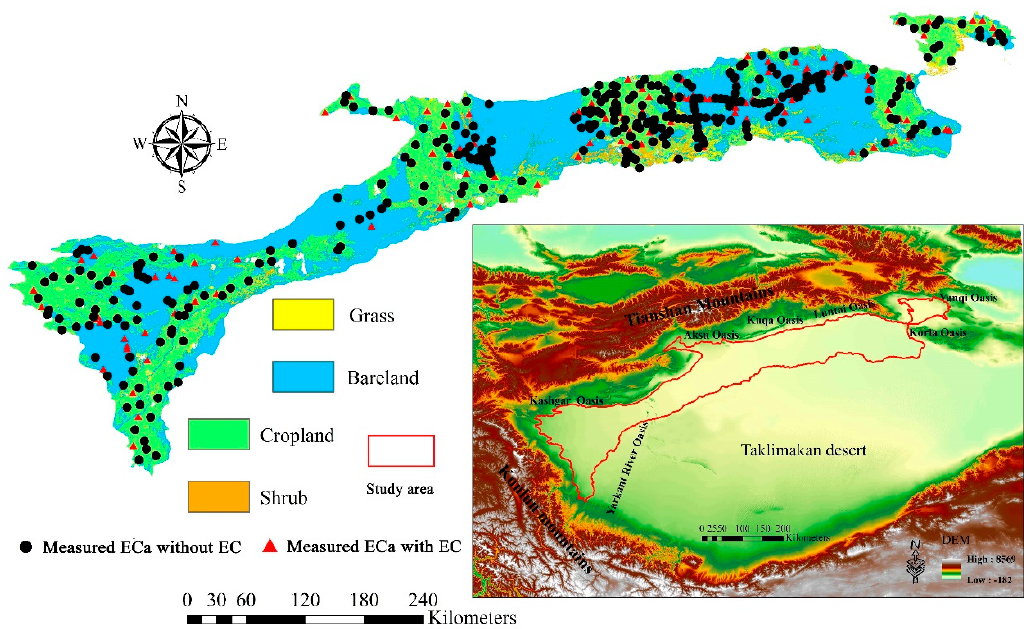
Figure 1. Study area setting within the Tarim Basin, Xinjiang, China and location of the 474 points measured by electromagnetic induction. Black solid represents that only apparent electrical conductivity (ECa) was collected, and the red triangle represents that the profile soil sample and ECa are collected simultaneously ( n = 132).